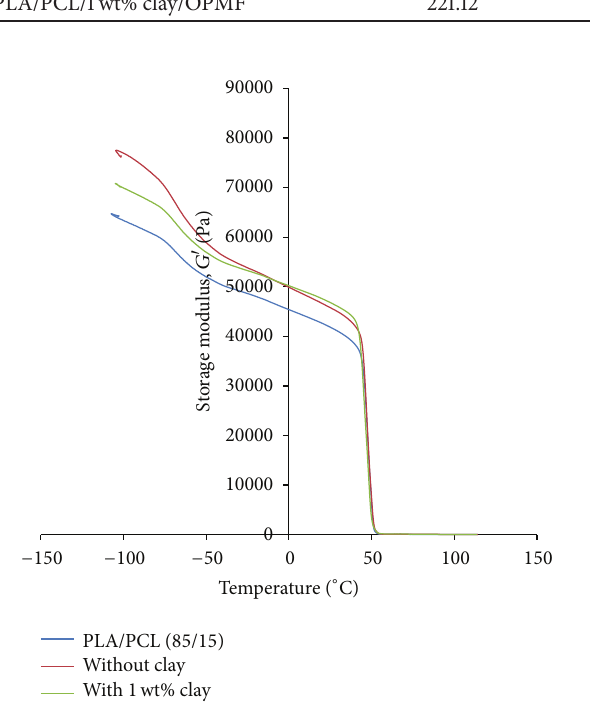
Figure 5: Storage modulus of PLA/PCL/OPMF biocomposites and PLA/PCL/1wt% clay/OPMF hybrid composites.